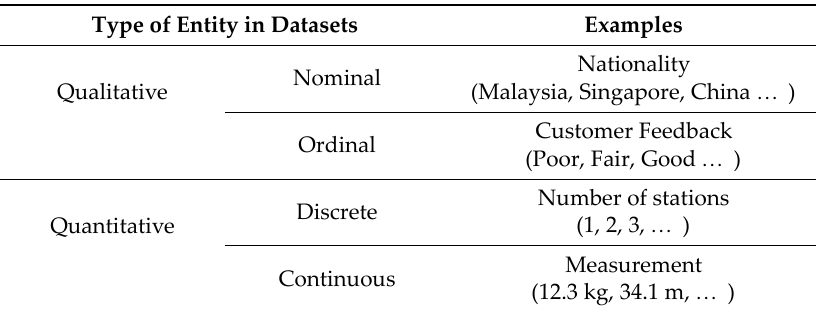
Table 1. Types of